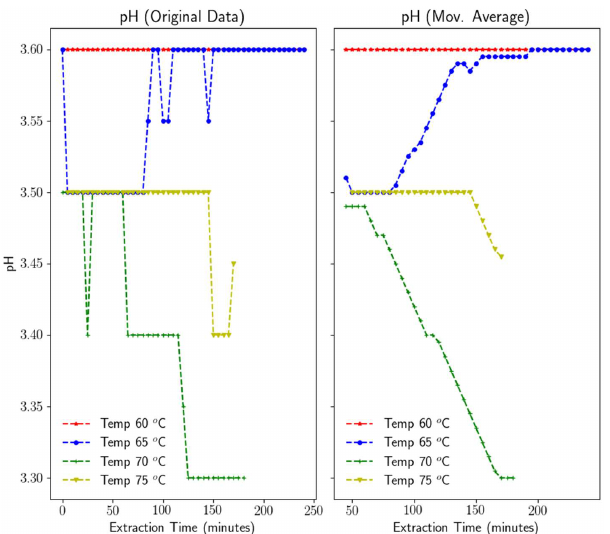
Figure 6. pH with different extraction times and at different temperatures.